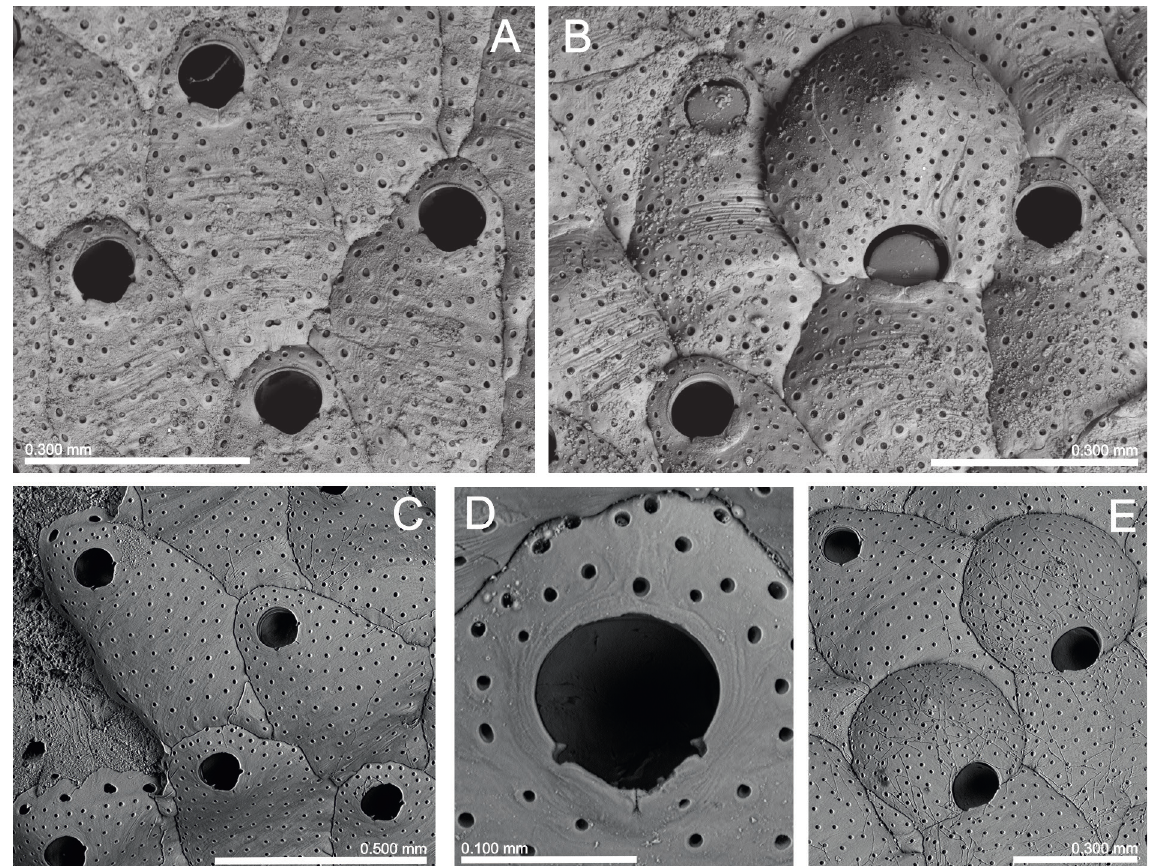
Fig. 2. Pulpeirina amoena (Jullien & Calvet, 1903) comb. nov. A . Autozooids (MOM INV-22502, lectotype of Schizoporella jullieni Calvet in Jullien & Calvet, 1903). B . Same, ovicellate and non- ovicellate zooids. C . Autozooids; note the distal dietella (MOM INV-22580). D . Same, primary orifice. E . Same,